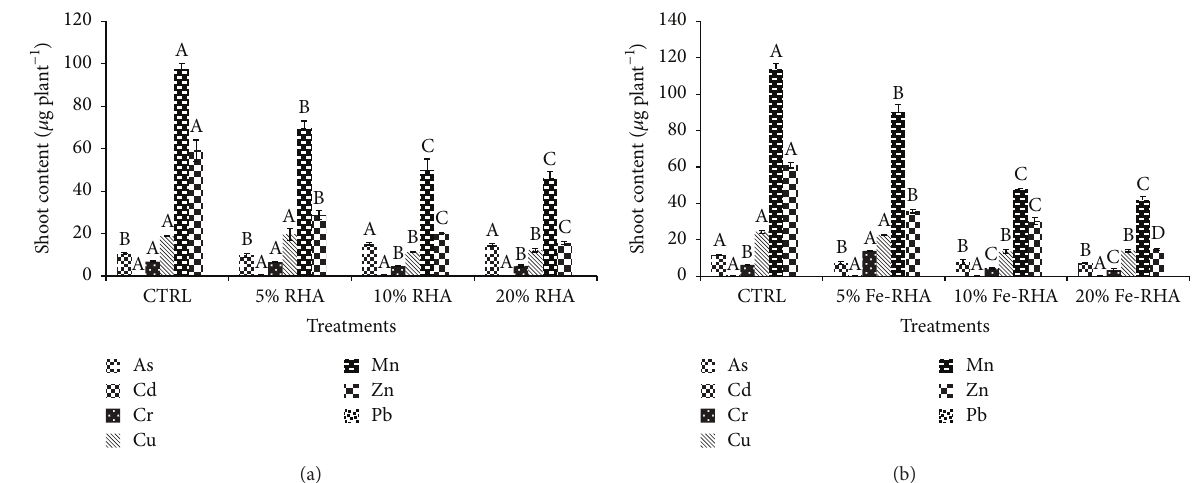
Figure 6: The uptake of As, Cd, Cr, Cu, Mn, Zn, and Pb ( 𝜇 g plant −1 ) in shoot of vetiver grass grown in gold mine amended with Fe-RHA and RHA (mean 𝑛 = 3 , ± SD). Different letters correspond to significant differences between rates of the same ash ( 𝑃 < 0.05 ). Pb was not detected.